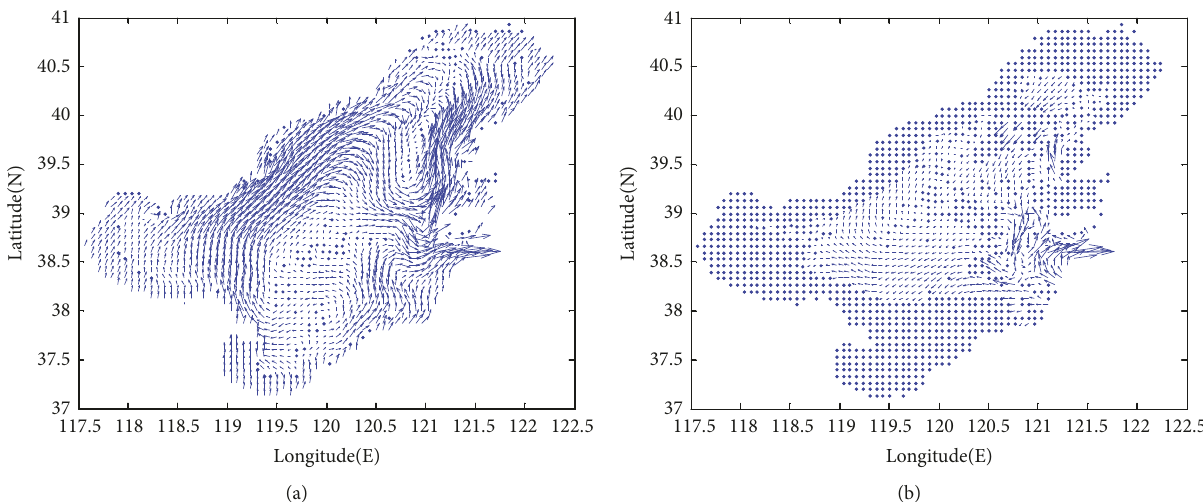
Figure 3: The average flow field of Bohai Sea in May 2009. Figures (a) and (b) are the average flow field of the first and third layers.